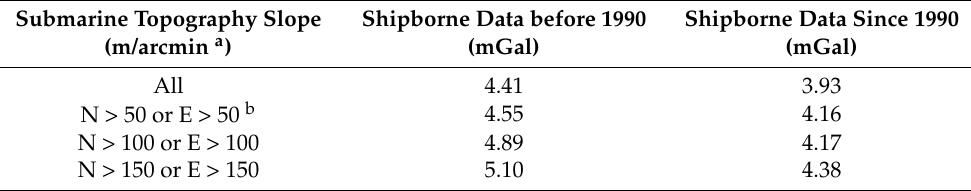
Table 1. Accuracy of shipborne data in different areas. Submarine Topography Slope (m/arcmin a )